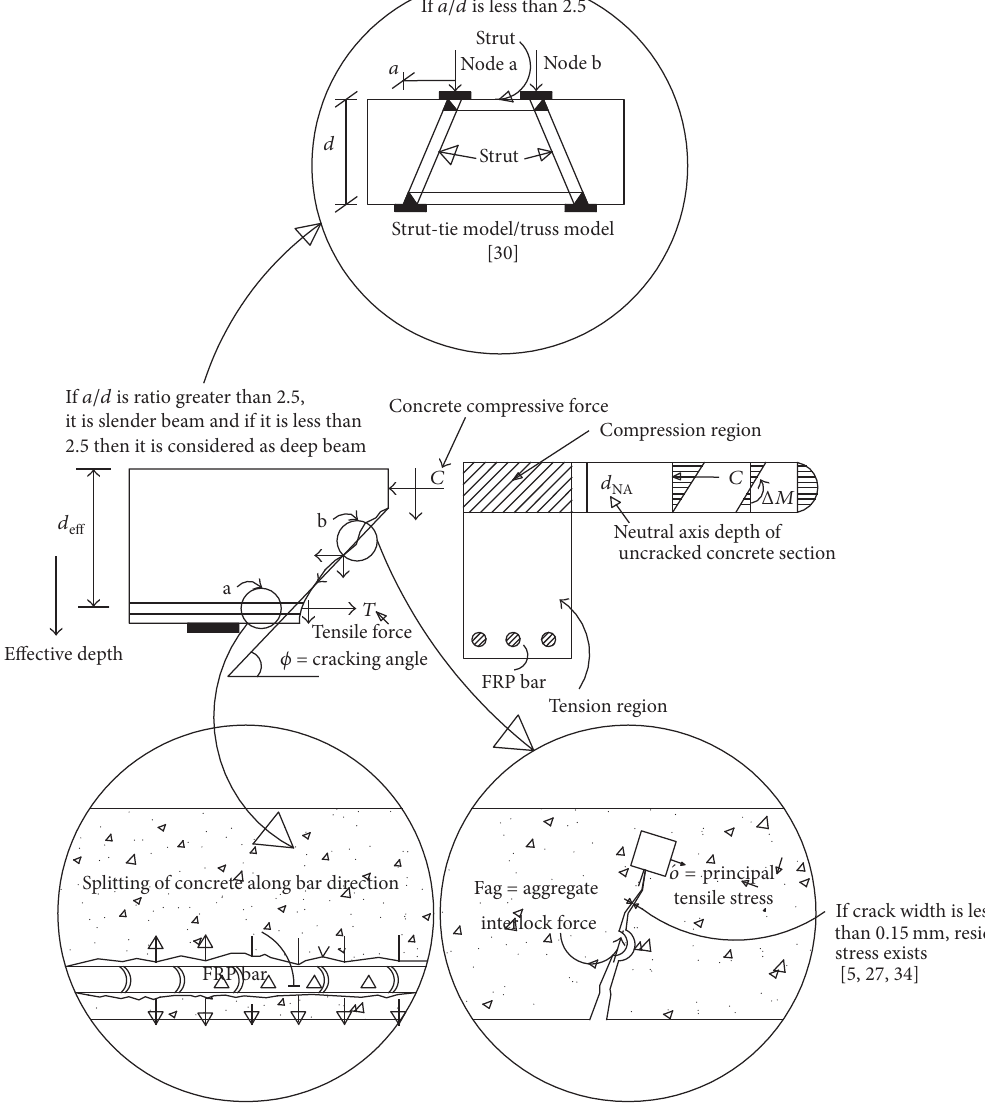
Figure 1: Shear mechanism of FRP reinforced concrete beams without stirrups